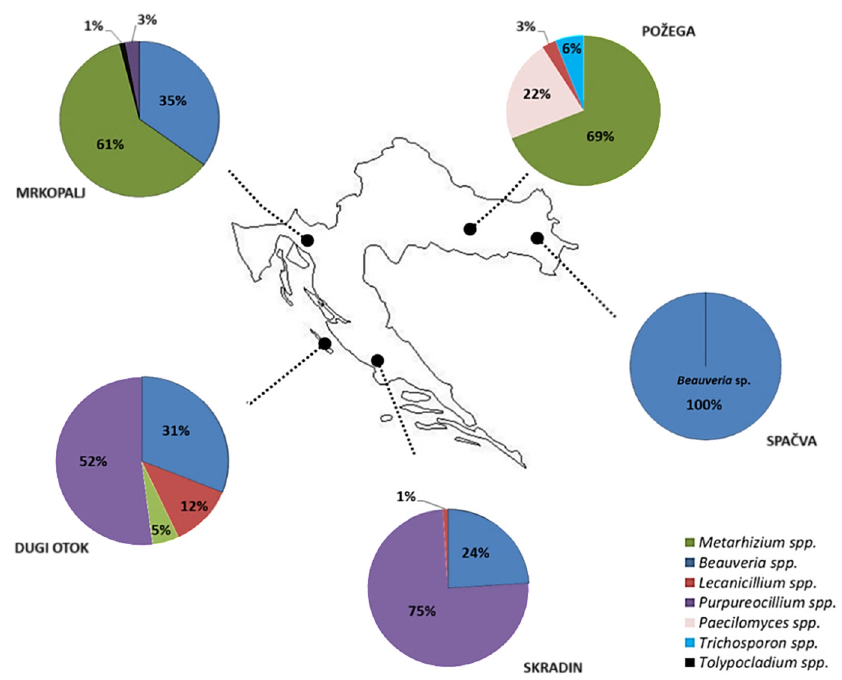
Figure 2. The share of identified species of fungi in the soil by location.